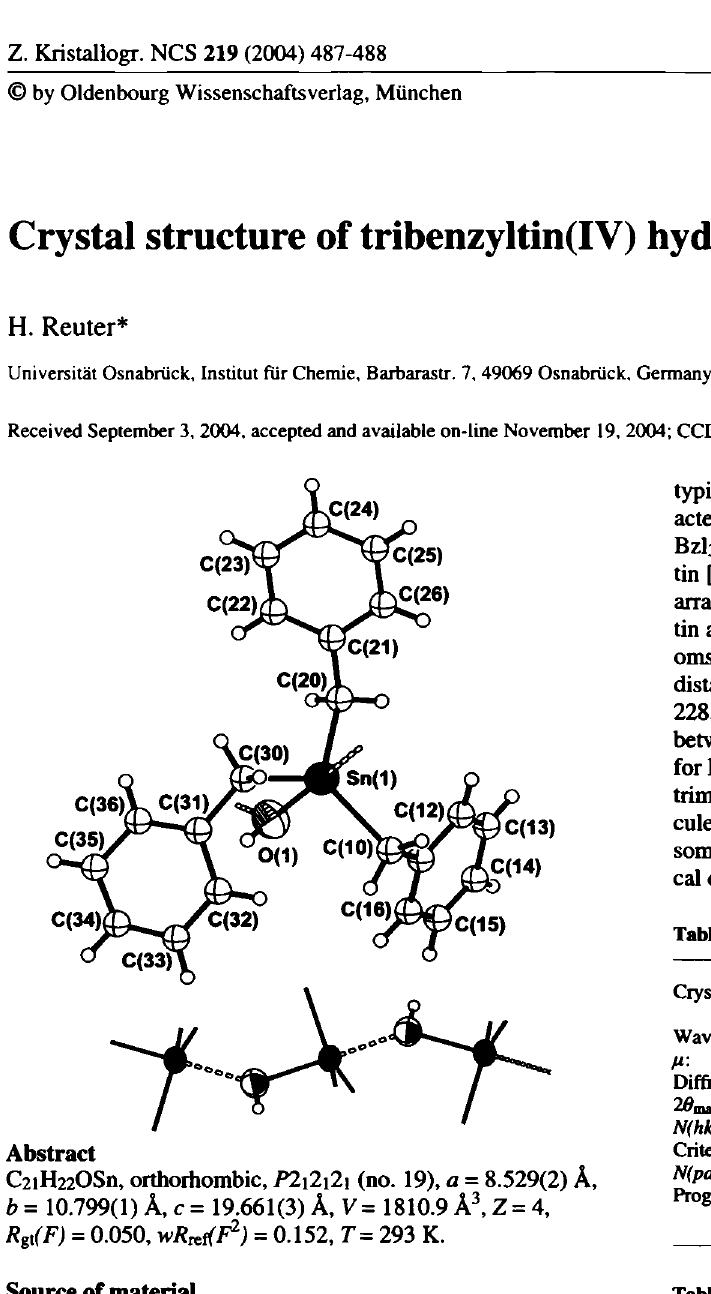
Table 2. Atomic coordinates and displacement parameters (in Â 2